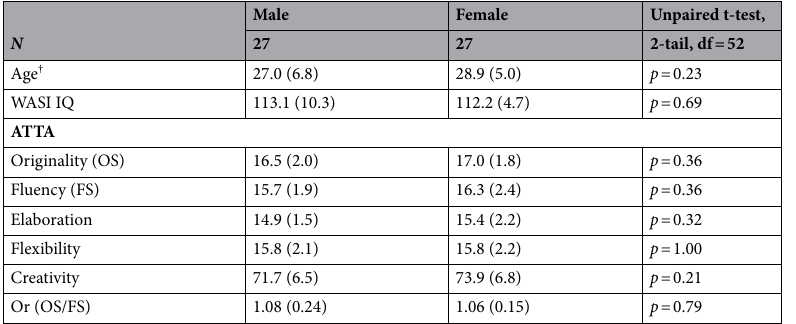
Table 1. Means and standard deviations for demographic and ATTA scores. Mean participant age, IQ and the sub-scores derived from the Abbreviated Torrance Test for Adults (ATTA). The originality score used in this study (Or) is the ATTA Originality score divided by the Fluence score. Other ATTA scores such as Elaboration, Flexibility and Creativity were not used in this study and are provided for the sake of